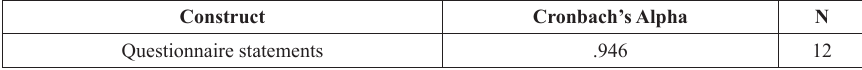
Table 5. Reliability statistics of the questionnaire answers